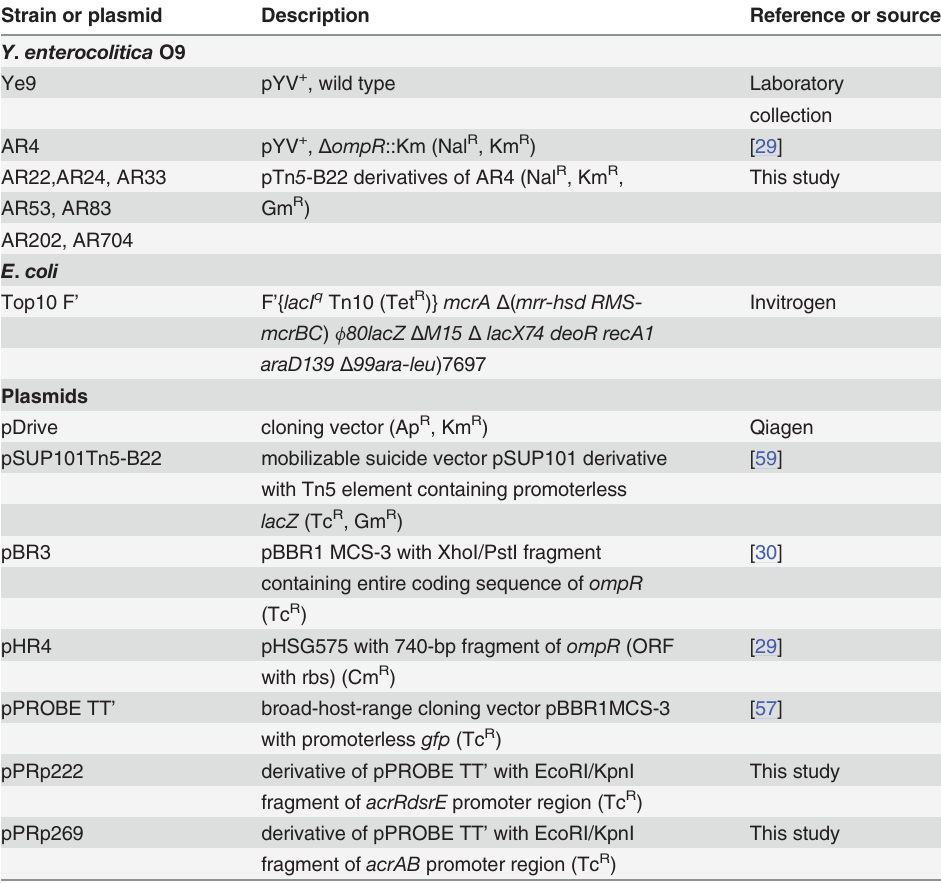
Table 4. Strains and plasmids used in this